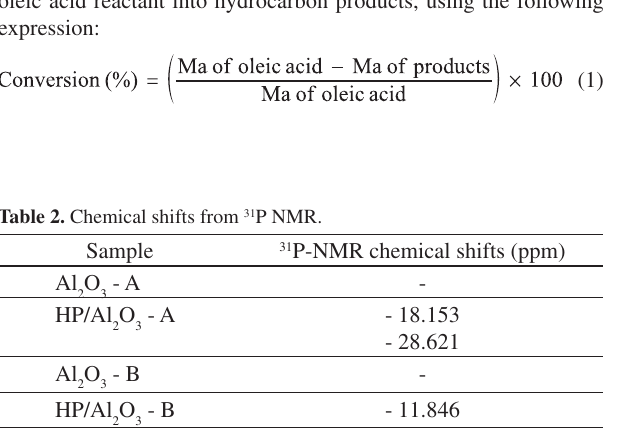
Table 3. Summarized results of the catalytic tests with oleic acid at 623 K.